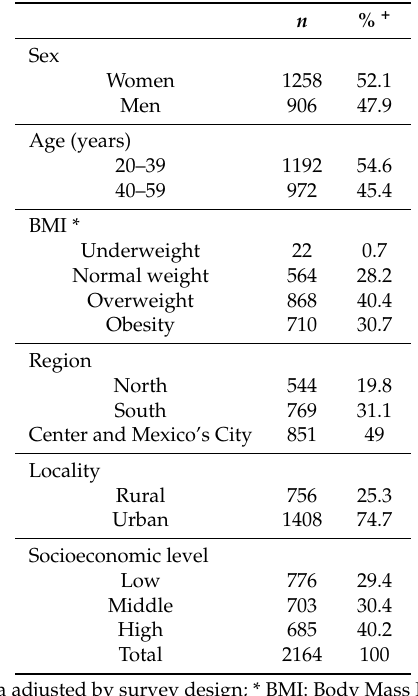
Table 1. Socio-demographic characteristics of participants. National Survey of Health and Nutrition (ENSANUT) 2012, Mexico.